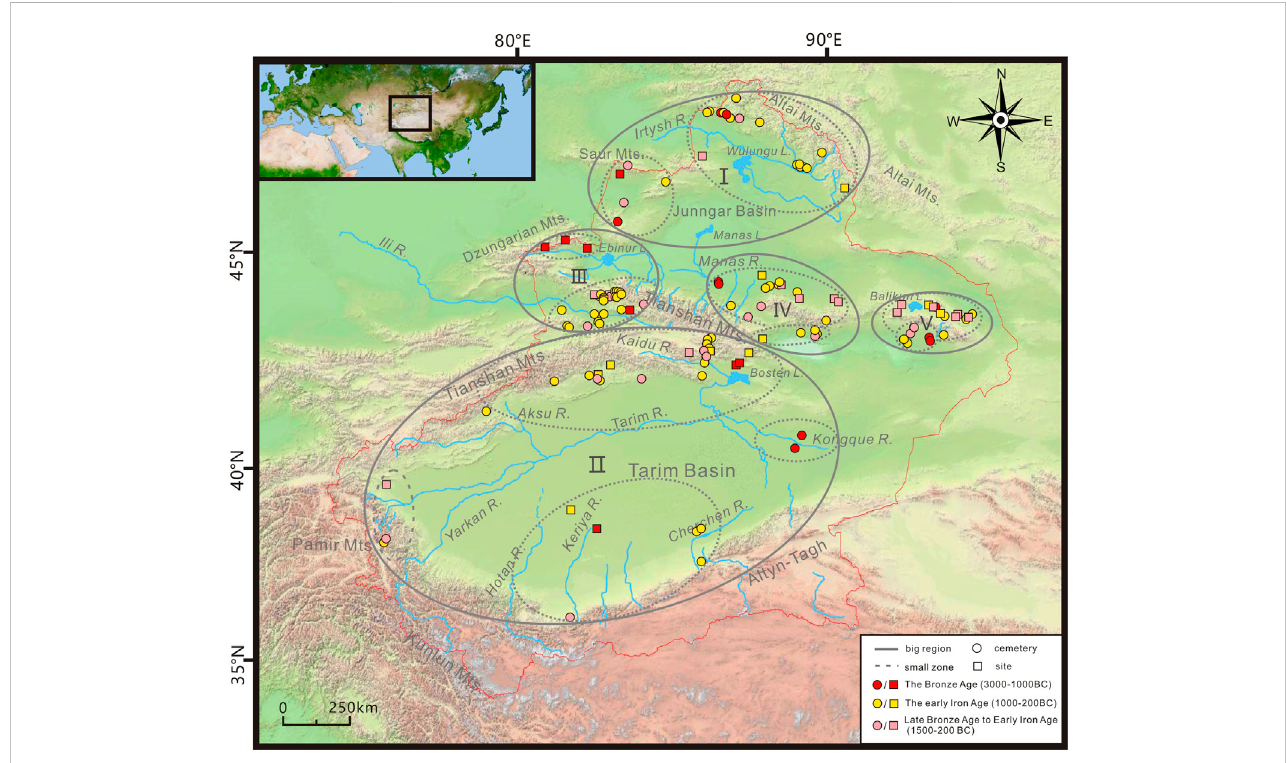
FIGURE 1 Map of Xinjiang, with the sites and the subregions of this study. I. Junggar Basin; II. Tarim Basin; III. Western Tianshan Mountains; IV. Middle Tianshan Mountains; V. Eastern Tianshan